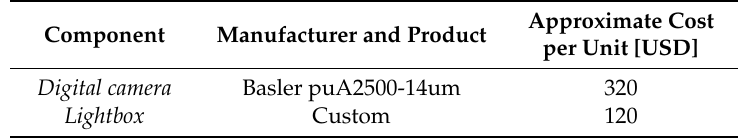
Table A2. Cost estimates for equipment for analyzing the low-cost passive